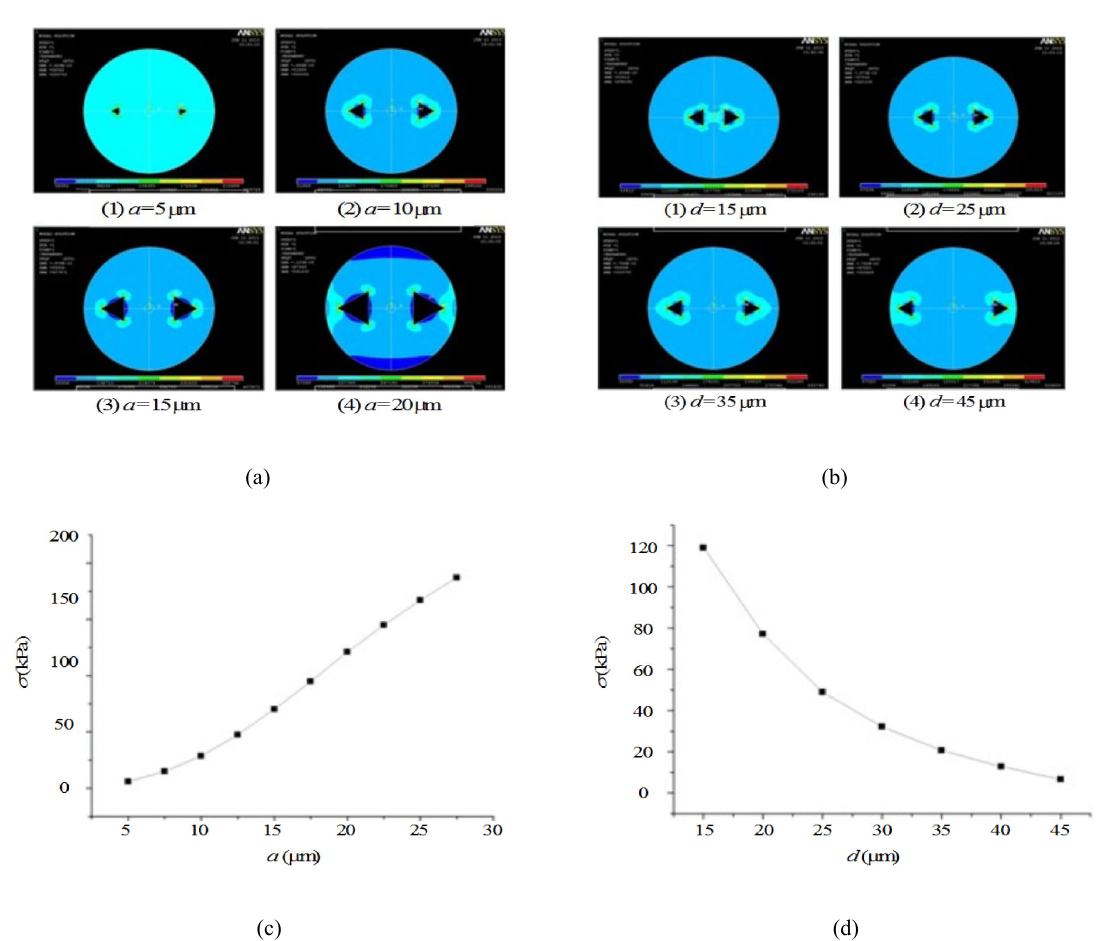
Fig. 7 Strain field distribution of different triangular-core side-hole fibers: (a) varying length a of triangular holes with fixed d = 31.25 µ m, (b) varying distance d with fixed a = 10 µ m, strain difference versus (c) length a and (d) distance d